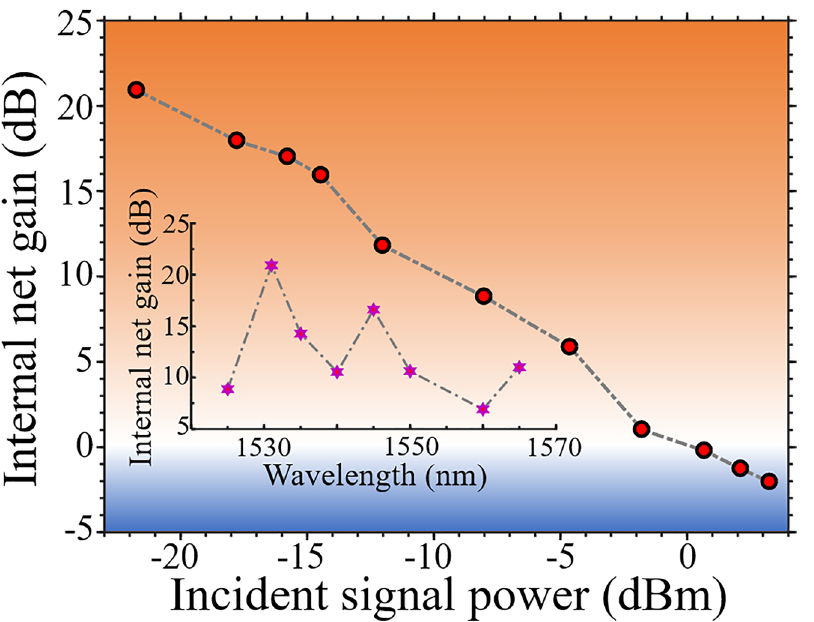
Figure 4: The internal net gain from Ta 2 O 5 - clad ampli fi er for increasing input signal powers. The small signal gain values at different signal wavelengths are shown in the